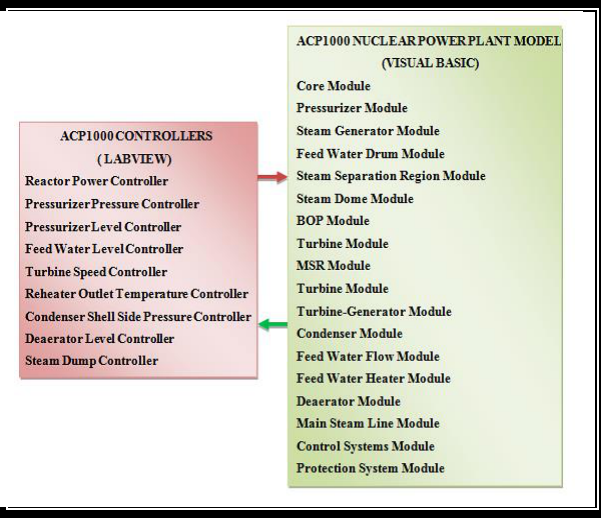
Fig. 1. Layout of ACP1000 modules and